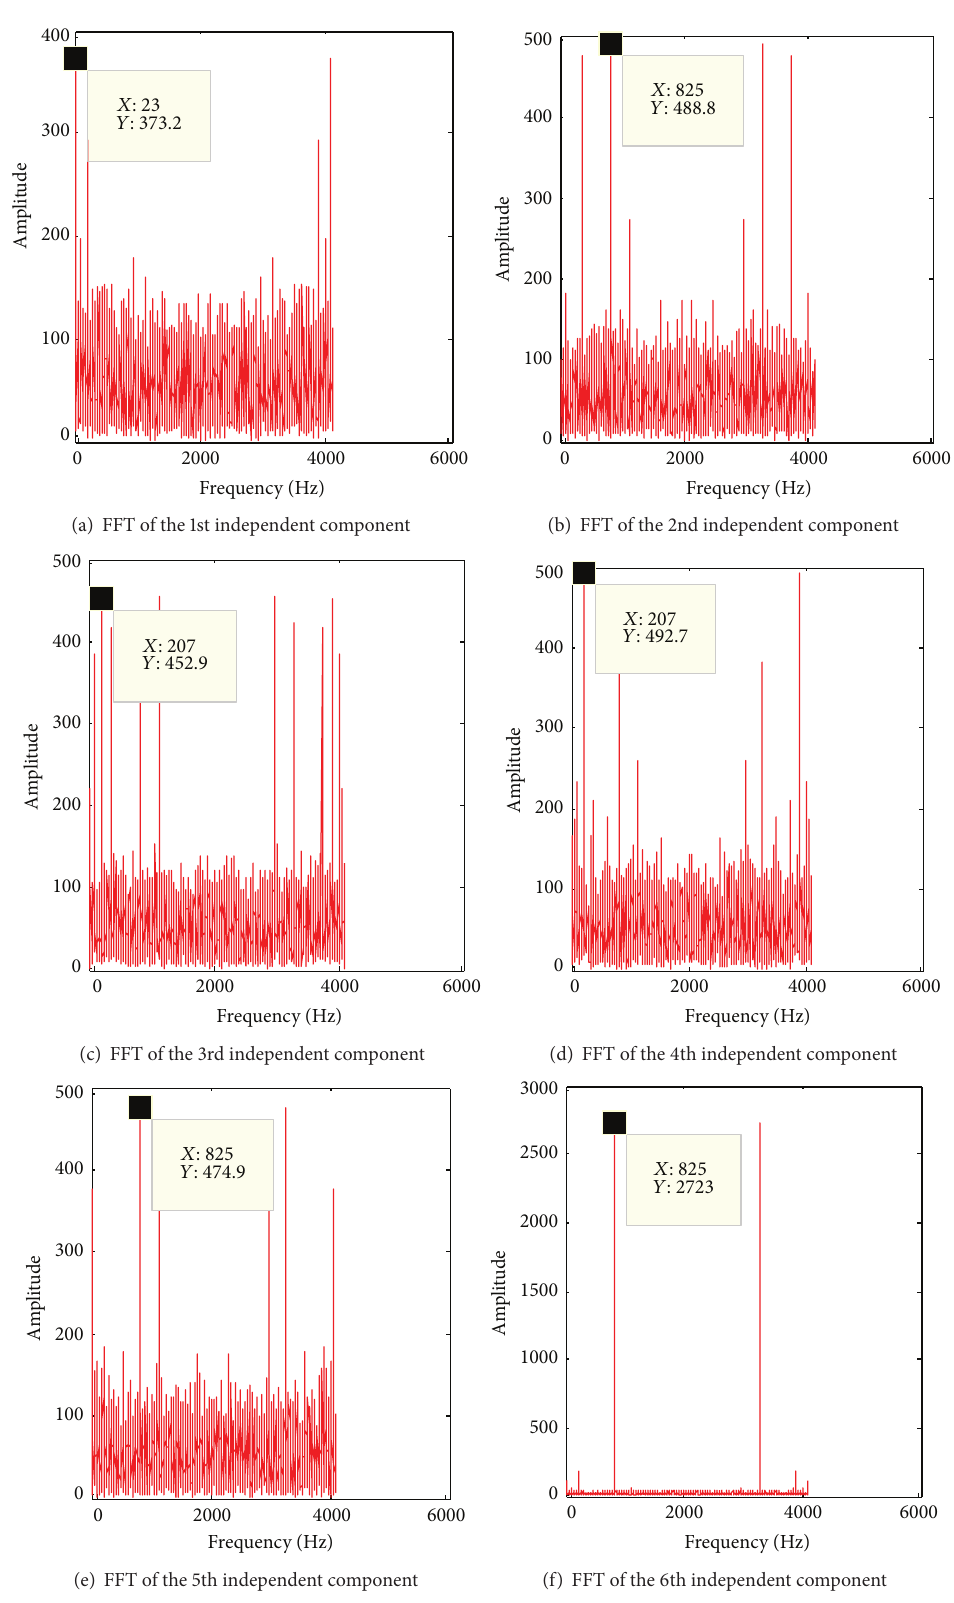
Figure 13: FFT of each independent component identified by maximization kurtosis with gradient descent method with measurement